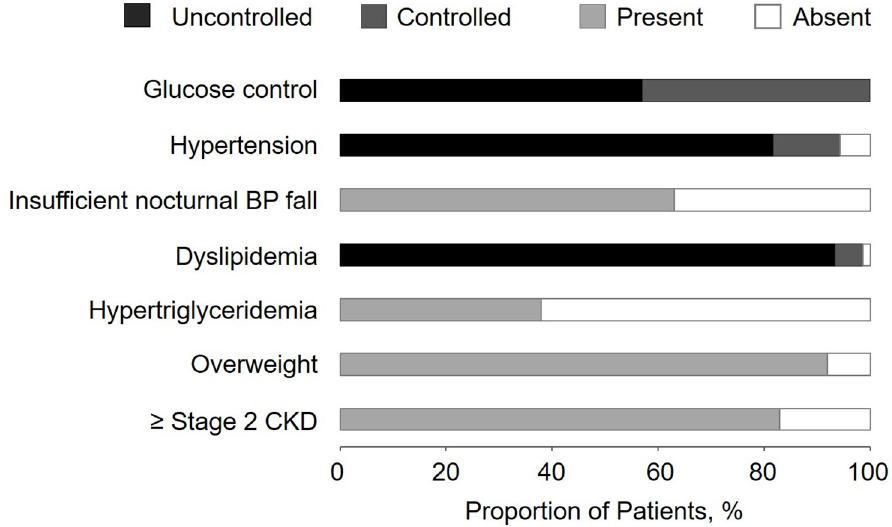
Fig 1. Proportion of patients with dyslipidemia (low-density lipoprotein cholesterol � 1.4 mmol/l), overweight (body mass index [BMI] � 25 kg/m 2 ), � stage 2 chronic kidney disease (CKD, glomerular filtration rate [GFR] � 90 ml/min/1.73 m 2 ), hypertension (systolic blood pressure [BP] � 140 mmHg and/or diastolic BP � 80 mmHg), obesity (BMI � 30 kg/m 2 ), insufficient nocturnal PB fall ( < 10% of the daily systolic average value), insufficient glucose control (HbA1c > 7.0%), � stage 3 CKD (GFR � 60 ml/min/1.73 m 2 ) and hypertriglyceridemia (fasting triglycerides � 1.7